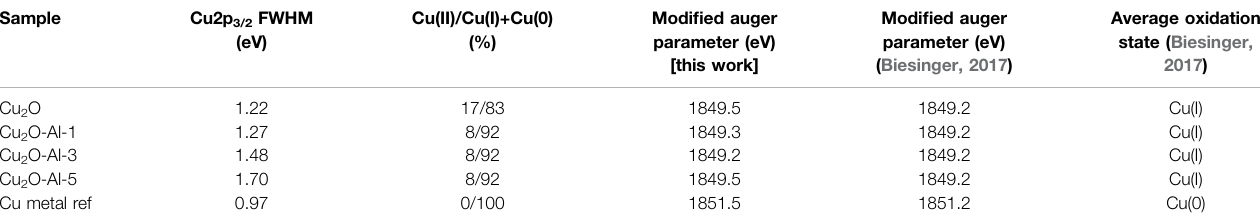
TABLE 4 | XPS parameters related to Cu2p3/2 peak FWHM, Cu(II)/Cu(I)+Cu(0) ratio, Modi fi ed Auger Parameters calculated for this work and reference values from the literature (Biesinger, 2017) and correlated average oxidation state for Cu, for samples Cu 2 O, Cu 2 O-Al-1/3/5 and Cu metal reference.